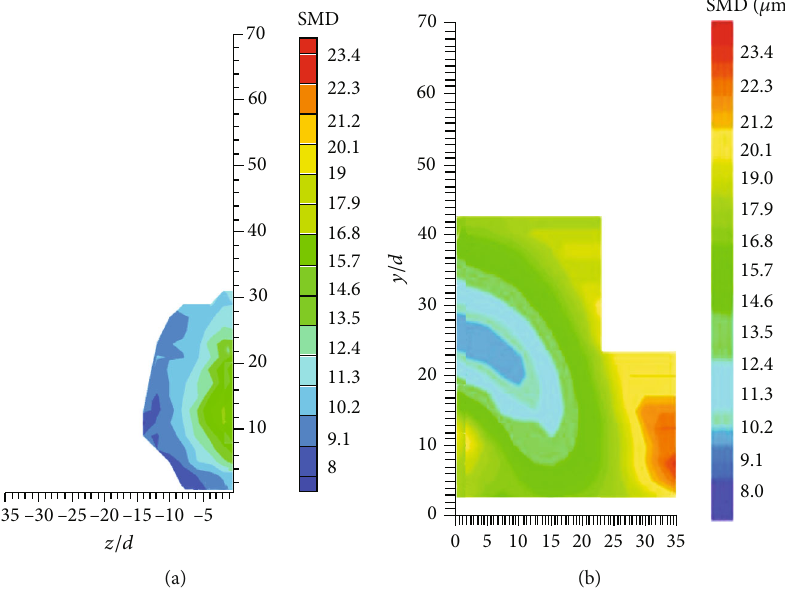
Figure 14: Comparison of SMD contour with the experimental result at x = 50mm : (a) numerical result and (b) experimental Figure 7 indicates the higher velocity of laminar fl ow com- pared with turbulent fl ow.